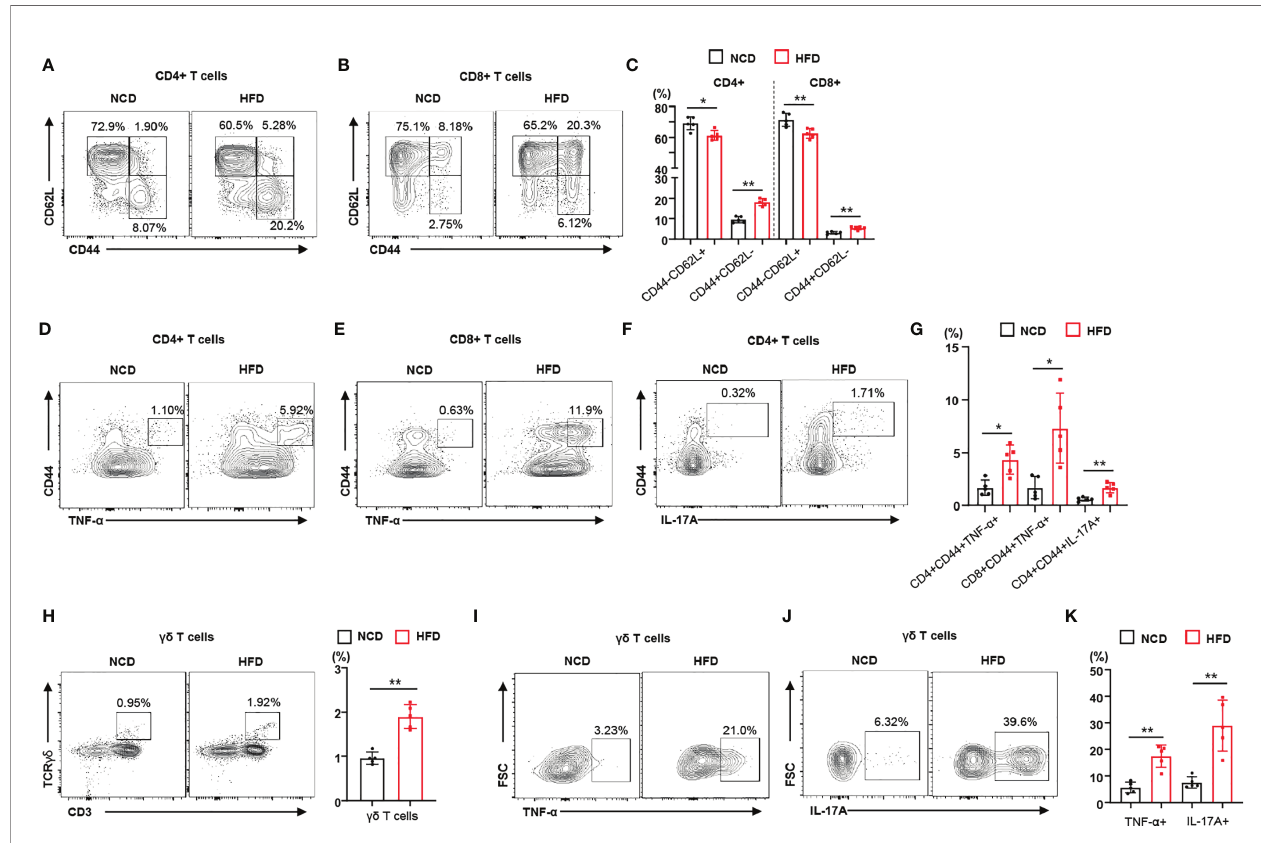
FIGURE 1 | Diet-induced obesity promotes the local in fl ammatory response in male mice with periodontitis. (A – C) Representative fl ow cytometry plots and percentages of CD44 + CD62L − and CD44 − CD62L − cells in the CD4 + and CD8 + T cell populations from submandibular lymph nodes of either NCD-fed (n = 5) or HFD-fed (n = 5) male mice with periodontitis 9 days after ligature placement. (D – G) Frequency of TNF- a - or IL-17A-producing cells in the populations of CD4 + or CD8 + T cells in periodontitis-induced mice fed with either a NCD or a HFD. (H) Frequency of gd T cells in submandibular lymph nodes of periodontitis-induced mice fed with either a NCD or a HFD. (I – K) Representative fl ow cytometry plots and percentages of either TNF- a - or IL-17A-producing cells in the population of gd T cells from periodontitis-induced mice fed with either a NCD or a HFD. Data represent mean values of more than three independent experiments. Data are expressed as the mean ± SEM. *p < 0.05, **p < 0.01 [ (C, G, H, K) : two ‐ tailed t